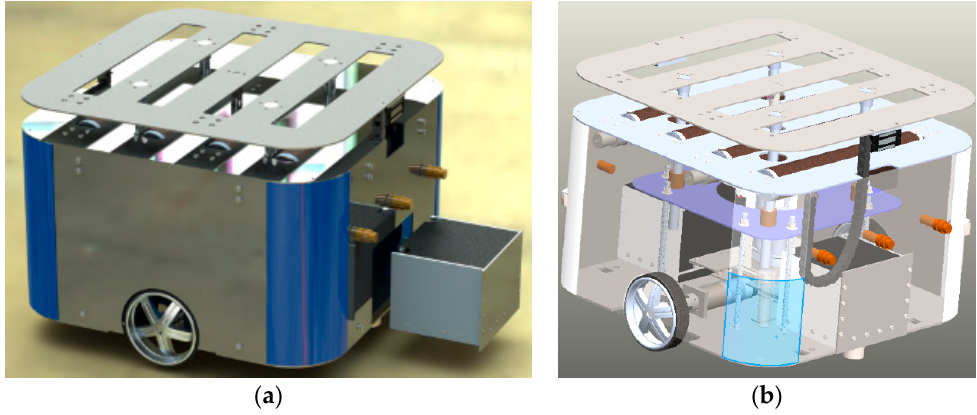
Figure 2. Overview of proposed autonomous vehicle: ( a ) outside view, and ( b ) inside view.